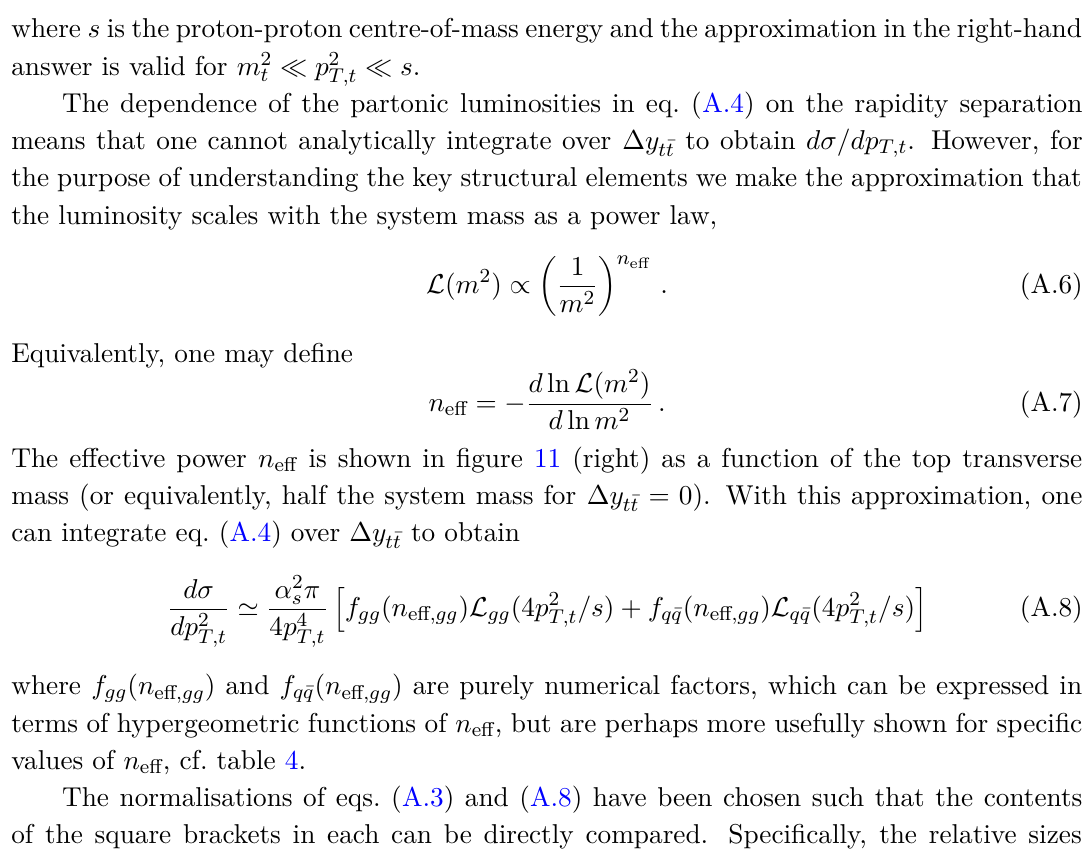
√ s = 13 TeV pp collisions and p T,t = 1 TeV . Right: effective of the partonic luminosities, as a function of H t ¯ t eff